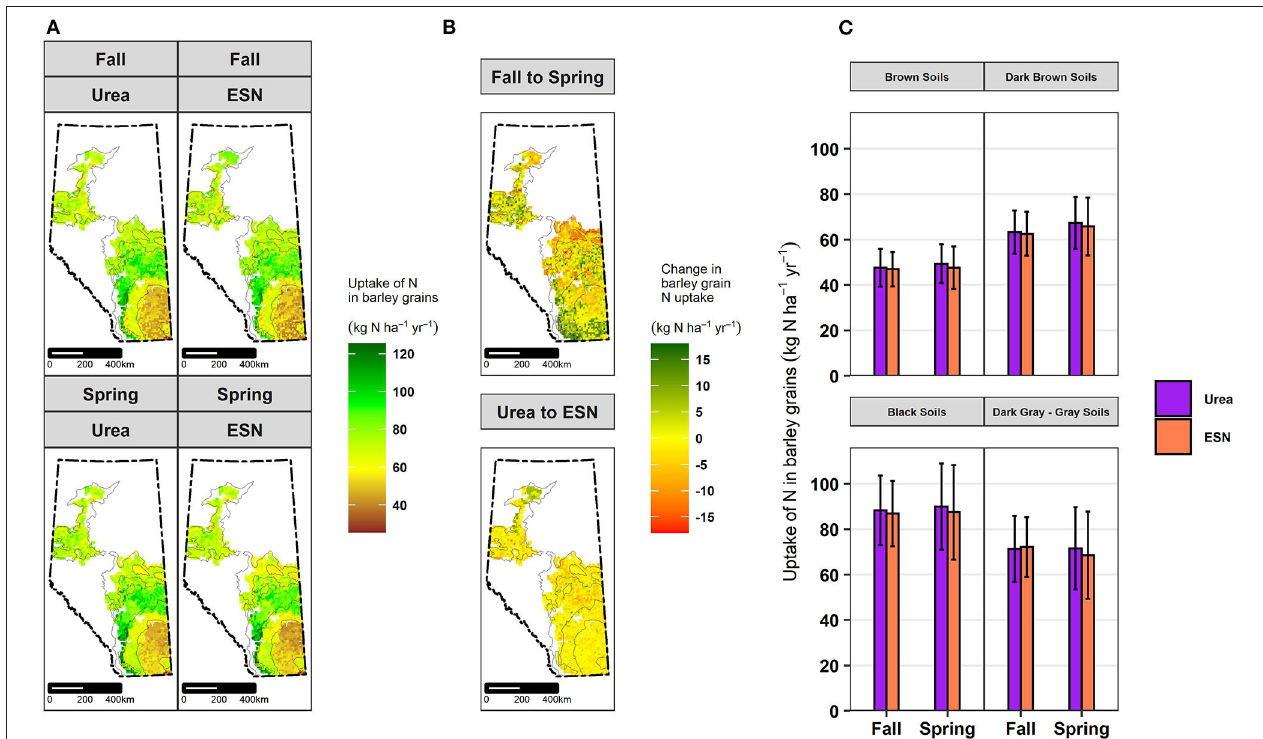
FIGURE 8 | (A) Spatial distribution of modeled annual nitrogen uptake into dryland or rainfed barley grains averaged over the simulation period (2011–2015) for each township for each of the fall and spring banded urea and ESN applications across mid-slope landforms of Alberta under simulated barley cultivation. (B) Spatial distribution of differences in modeled dryland barley grain nitrogen uptake for fall vs. spring and urea vs. ESN applications averaged over the simulation period (2011–2015) for each township across mid-slope landforms of Alberta under simulated barley cultivation. A positive change represents an increase in grain nitrogen uptake for a change from fall to spring or from urea to ESN and vice versa. The white areas on the map were not modeled based on the selection criteria as described in section Methodology and Model Inputs. The thick dashed lines on the maps represent Alberta’s provincial boundary, and the thin black lines within the maps demarcate soil group areas. (C) Soil group-wise averages of modeled dryland barley grain nitrogen uptake for fall vs. spring banding and urea vs. ESN applications averaged over the simulation period (2011–2015) for all the townships in each soil group area across mid-slope landforms of Alberta under simulated barley cultivation. Error bars represent standard deviations illustrating spatiotemporal variations in modeled grain nitrogen uptake within each soil group